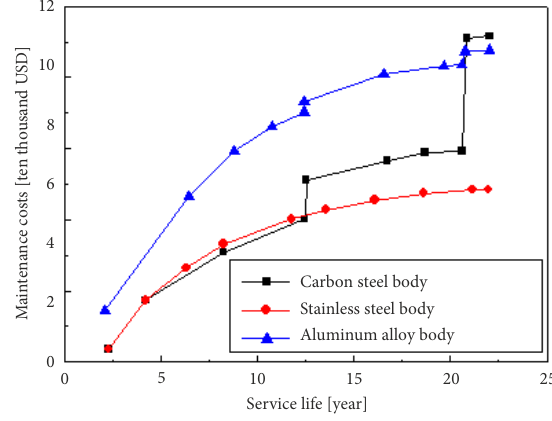
Figure 1. Maintenance costs of car body Figure 2. Total cost of car body